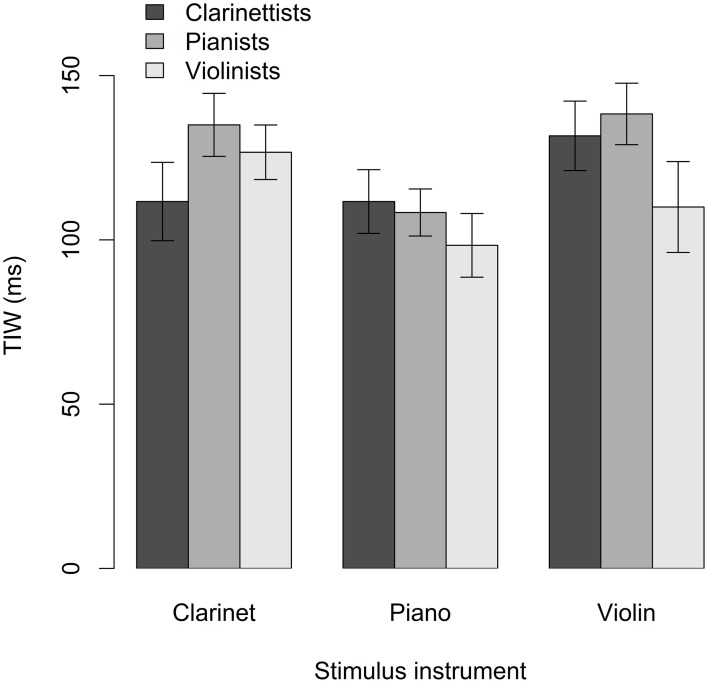
Mean TIW across stimulus instruments and expertise groups. Error bars indicate standard error.